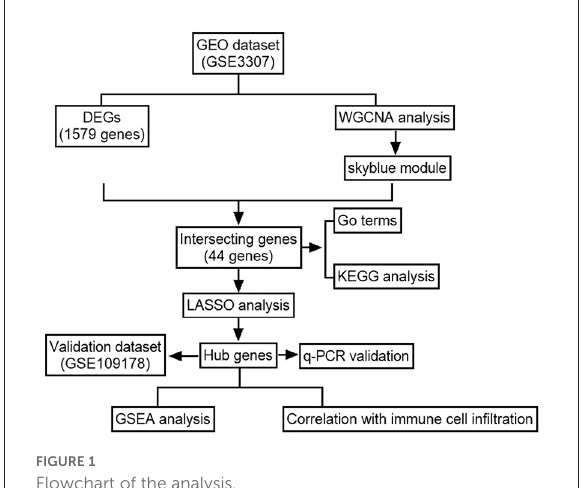
FIGURE1 Flowchart of the